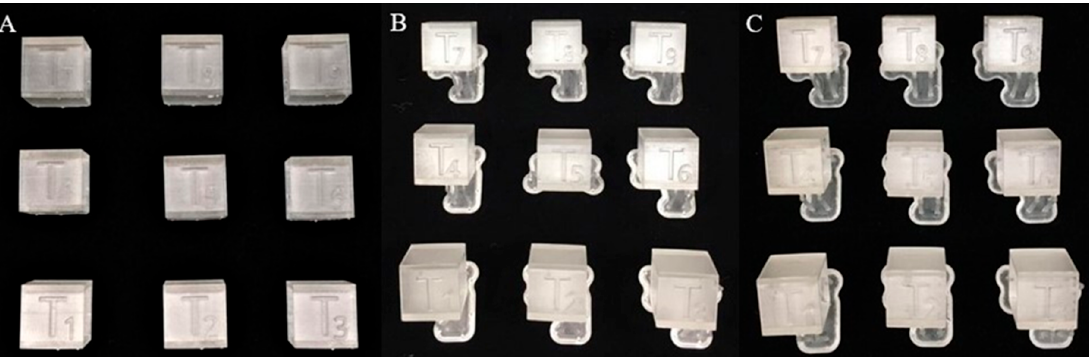
Figure 3. 3D printed test bodies in a cured state: ( A ) Group 3 (SLA-LT) test bodies (T1–T9) after removal of support structures; ( B ) Group 4 (SLA-Luxa) test bodies (T1–T9) before removal of support structures; and ( C ) Group 5 (SLA-NextDent) test bodies (T1–T9) before removal of support structures.